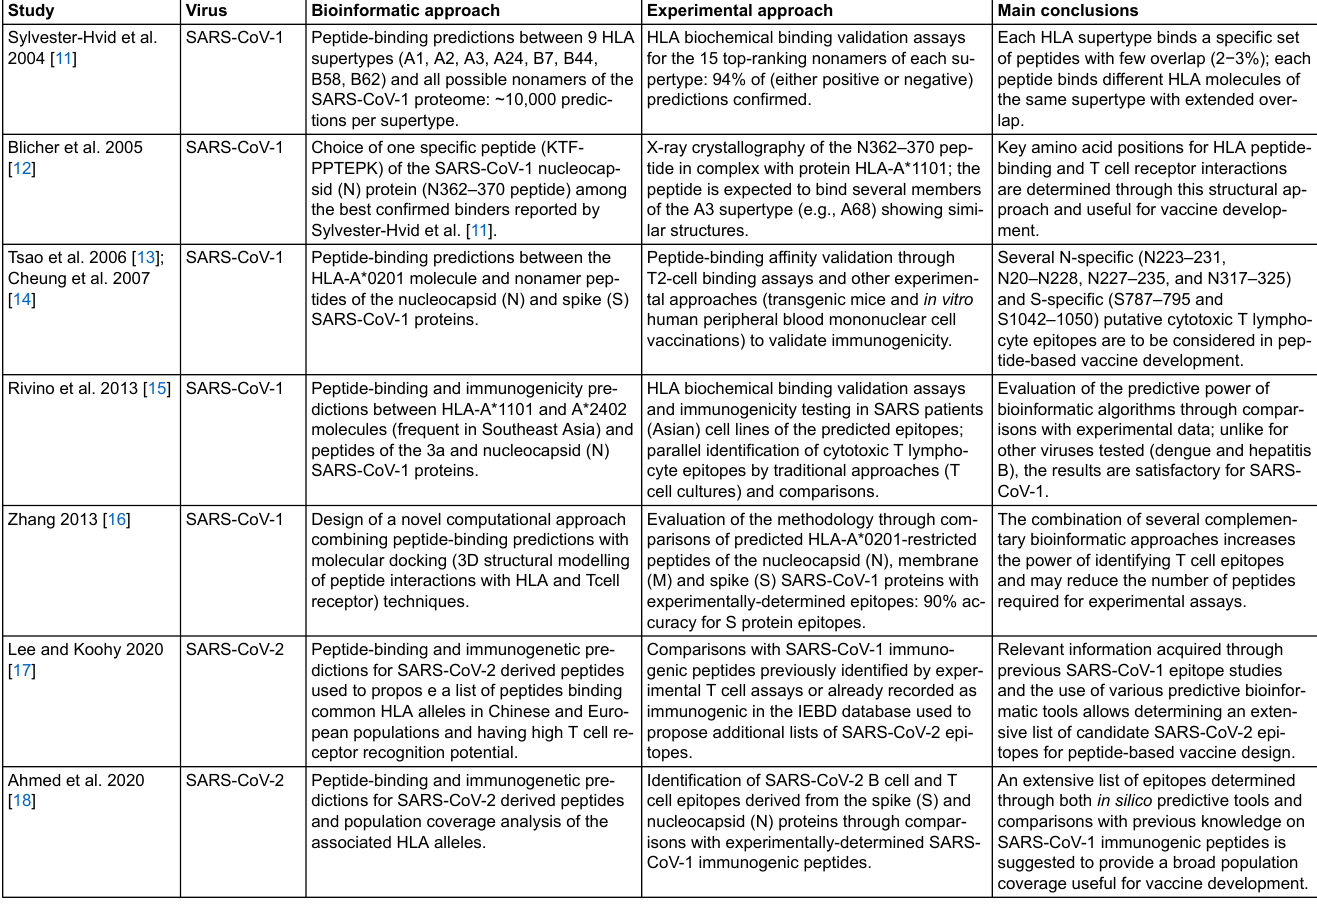
Table 2: HLA-related bioinformatic and experimental studies carried out to determine SARS-CoV-1 / CoV-2 immunogenic epitopes for vaccine design.